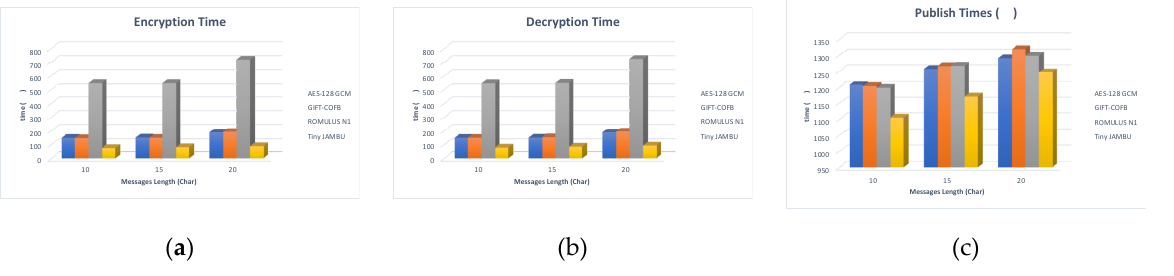
Figure 9. Lightweight Cryptographic Encryption and Decryption Performance on STM32L4 on WiFi Network Used Registered Account. ( a ) Encryption Time; ( b ) Decryption Time; ( c ) Message Publication Time to MQTT Server.